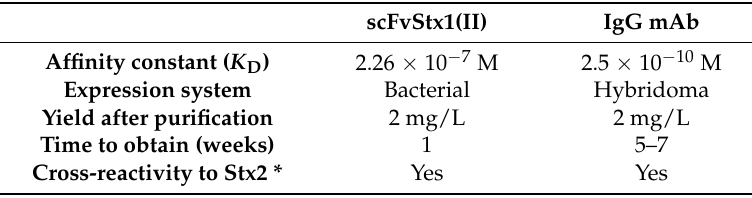
Table 1. Comparison of scFvstx1 and IgG parental antibody. IgG characteristics were obtained from Rocha et al.